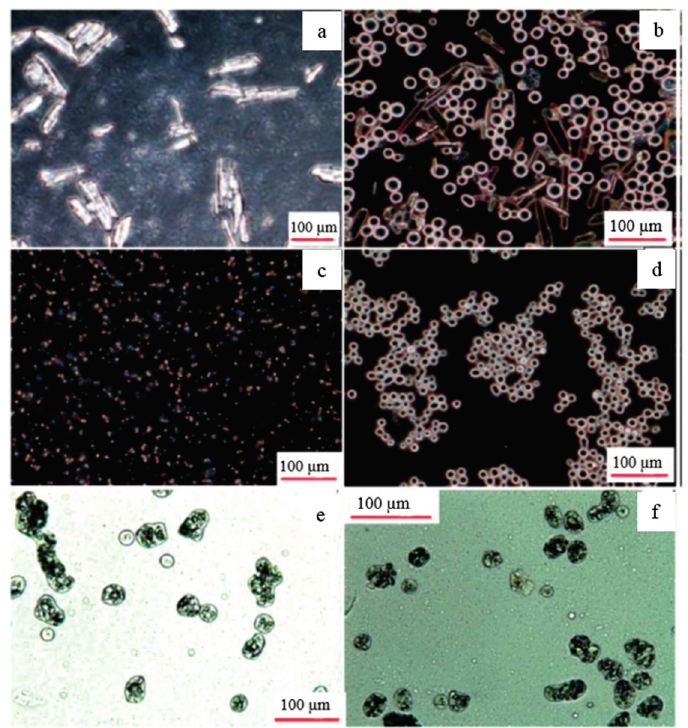
Figure 6. Photomicrographs showing native ibuprofen ( a ) that is not encapsulated by the coacervate ( b ) in presence of surfactant; Micronized ibuprofen ( c ) when added to coacervates without surfactant ( d ) successfully encapsulated by the coacervates ( e , f